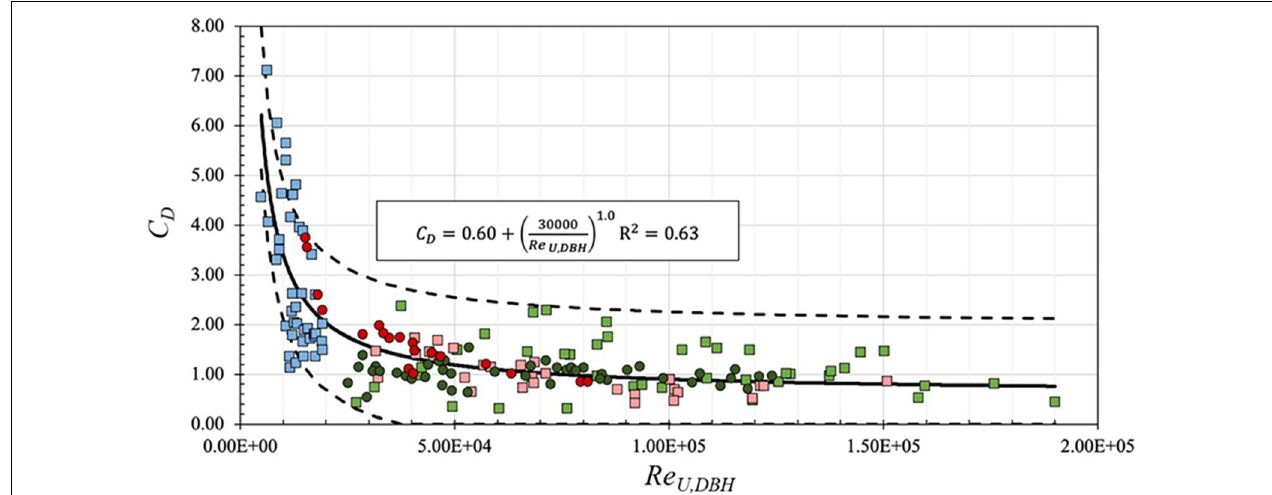
FIGURE 10 | Drag coefficient, C D , versus the Reynolds number, Re U , DBH , on a linear scale for data from present study random (dark red circles) and regular (light red squares) waves, Maza et al. (2019) random (dark green circles) and regular (light green squares) waves, and Chang et al. (2019) regular (light blue squares) waves. Solid black line indicates the fitted equation with asymptote value 0.6 [Equation (8)]. Dashed black lines indicate 95% confidence